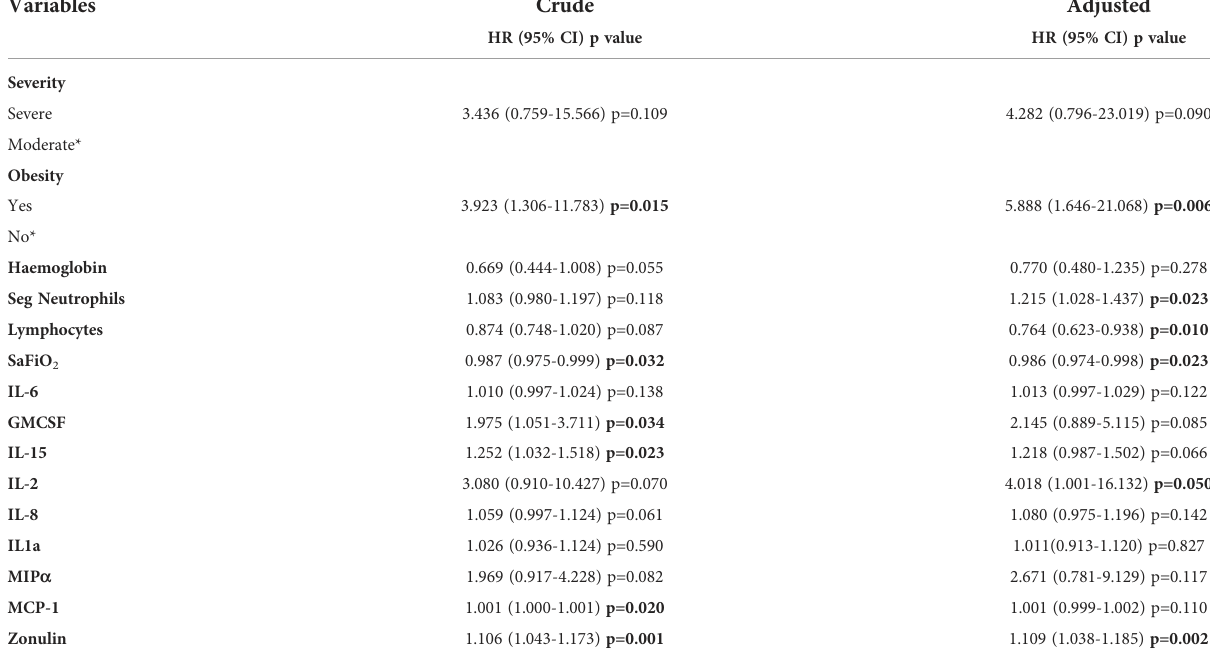
TABLE 5 Crude and adjusted* Cox regression of different factors for survival analysis.